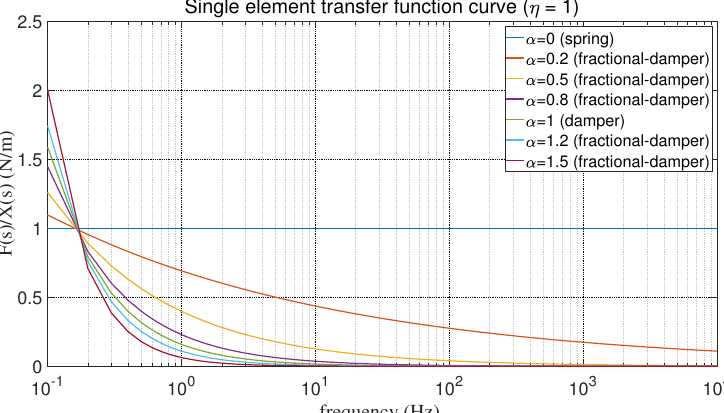
Figure 7. Transfer function curve of a single model